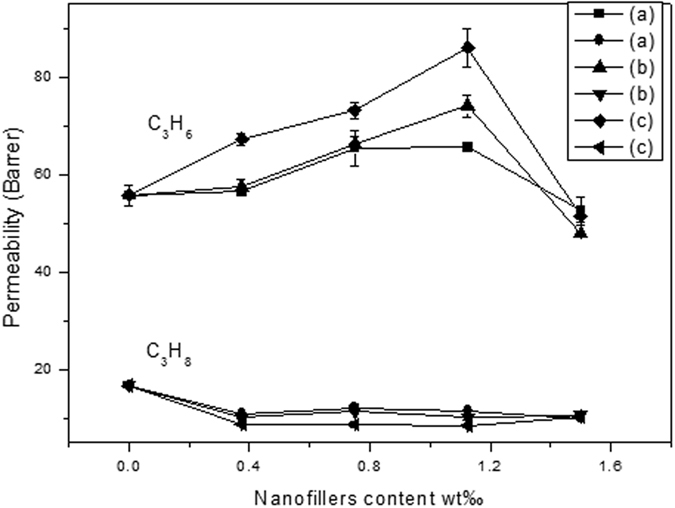
Effect of three graphene nanosheets content in EC polymer matrix on the permeability of C3H6 and C3H8: (a) L-rGO MMMs; (b) rGO MMMs; (c) nanoporous rGO MMMs. (Feed pressure at 0.1 MPa, temperature at 298 K).